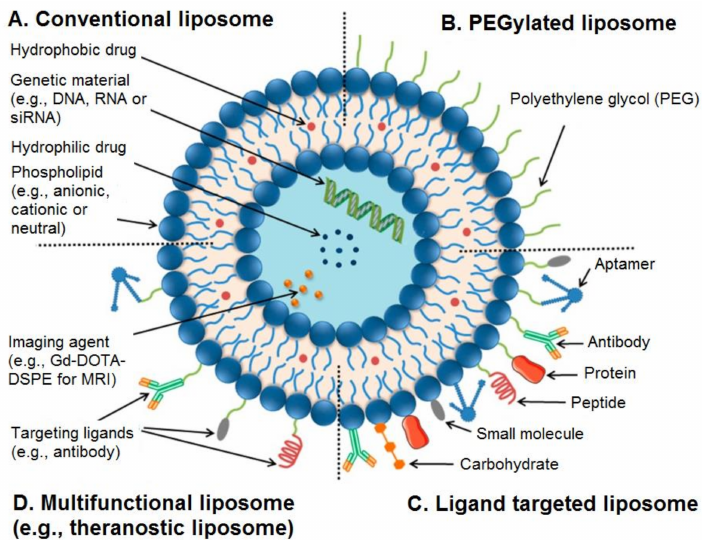
Figure 1. Structure of conventional and functionalised liposomes: ( A ) conventional liposomes comprising phospholipids; ( B ) PEGylated/stealth liposomes containing a layer of polyethylene glycol (PEG); ( C ) targeted liposomes containing a specific ligand to target a cancer site; and ( D ) multifunctional liposomes, which can be used for diagnosis and treatment of solid tumours. Adapted from Creative Commons Attribution License